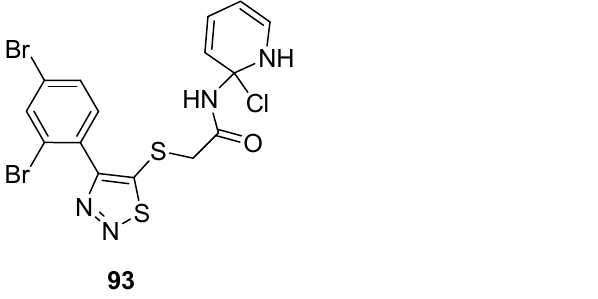
Figure 5. Anti-HIV activity of 5-(2,4-dibromophenyl)-1,2,3-thiadiazole 93 .